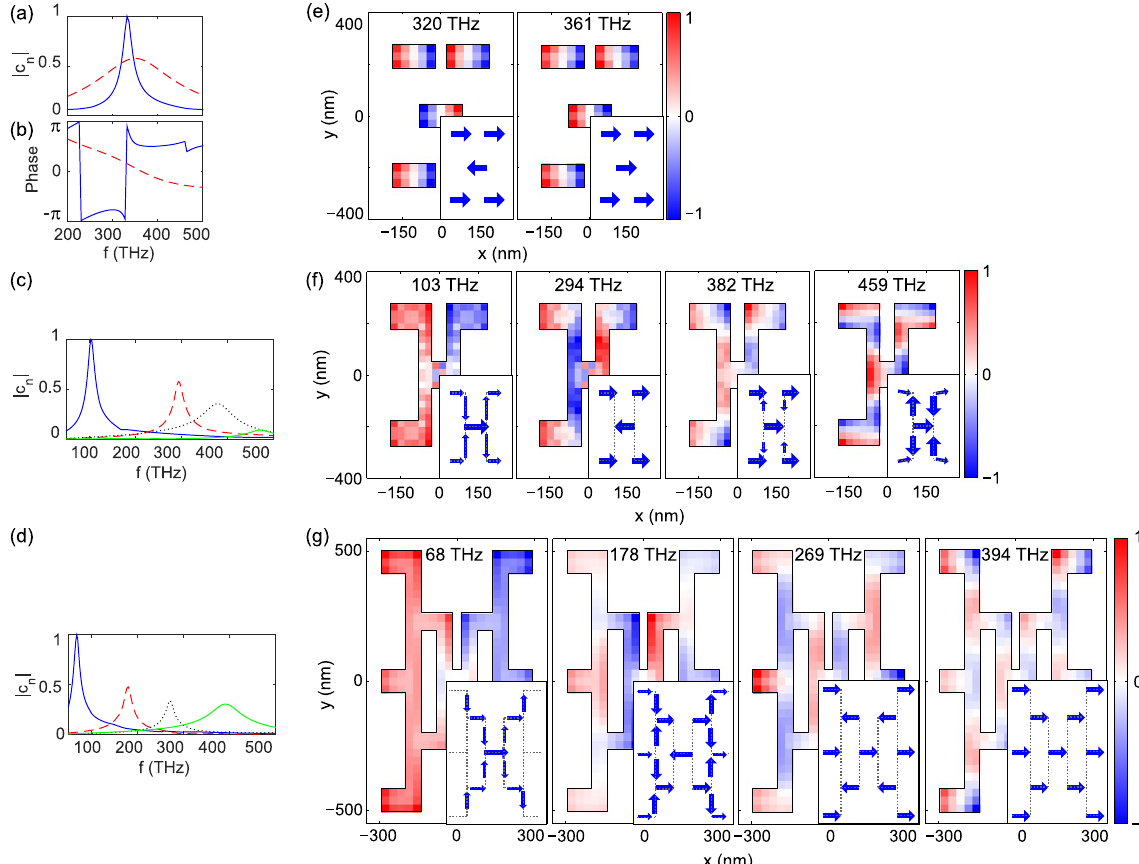
Figure 4. ( a ) Amplitude (normalized to the maximum) and ( b ) phase of the coupling coefficients of the the superradiant (blue solid lines) and subradiant (red dashed lines) modes supported by the pentamer. ( c – d ) Amplitude (normalized to the maximum) of the coupling coefficients of eigenmodes of ( c ) the first and ( d ) the second generations of the dendritic antennas. Normalized instantaneous charge distribution of eigenmodes obtained from V-MoM within the Γ 4 representation for ( e ) the pentamer, ( f ) the first and ( g ) the second generations of the dendritic antennas. Insets illustrate the directions of instantaneous net